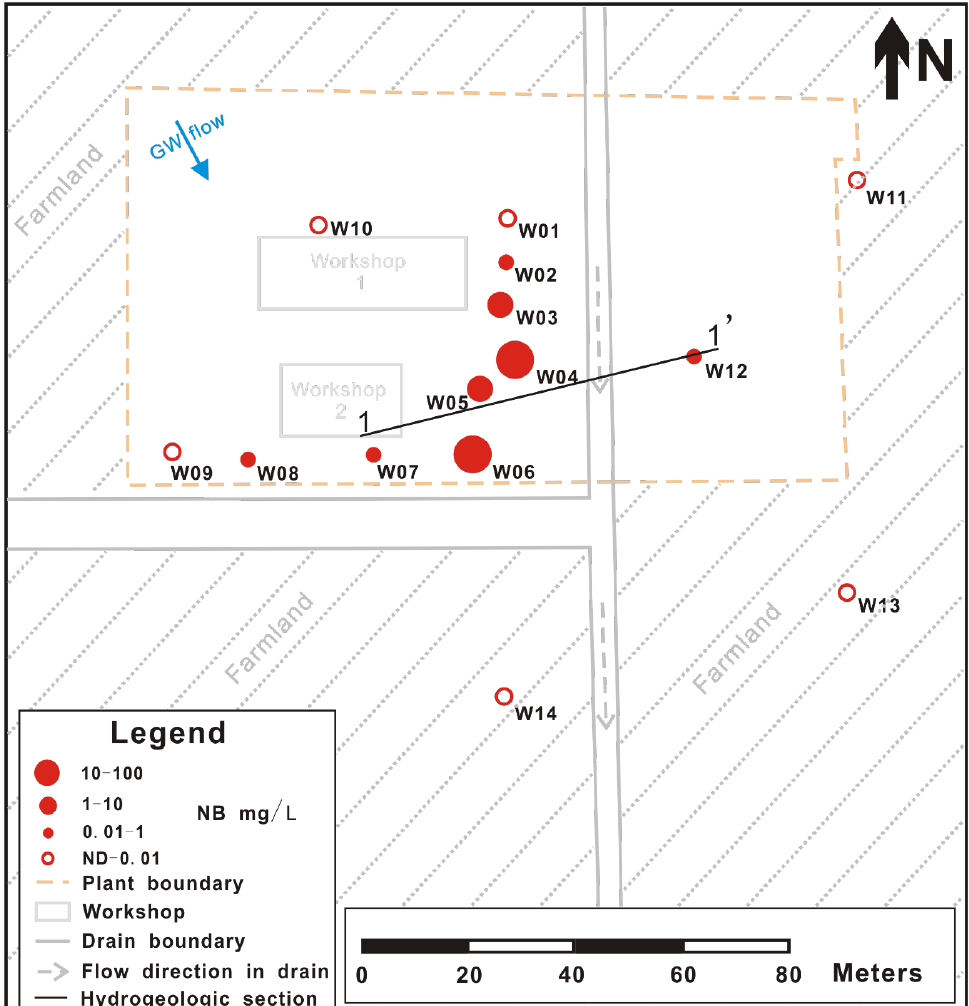
Figure 3. Site map of the study area. Red dots represent NB concentrations in monitoring wells with dot size corresponding to concentration range identified in the legend.